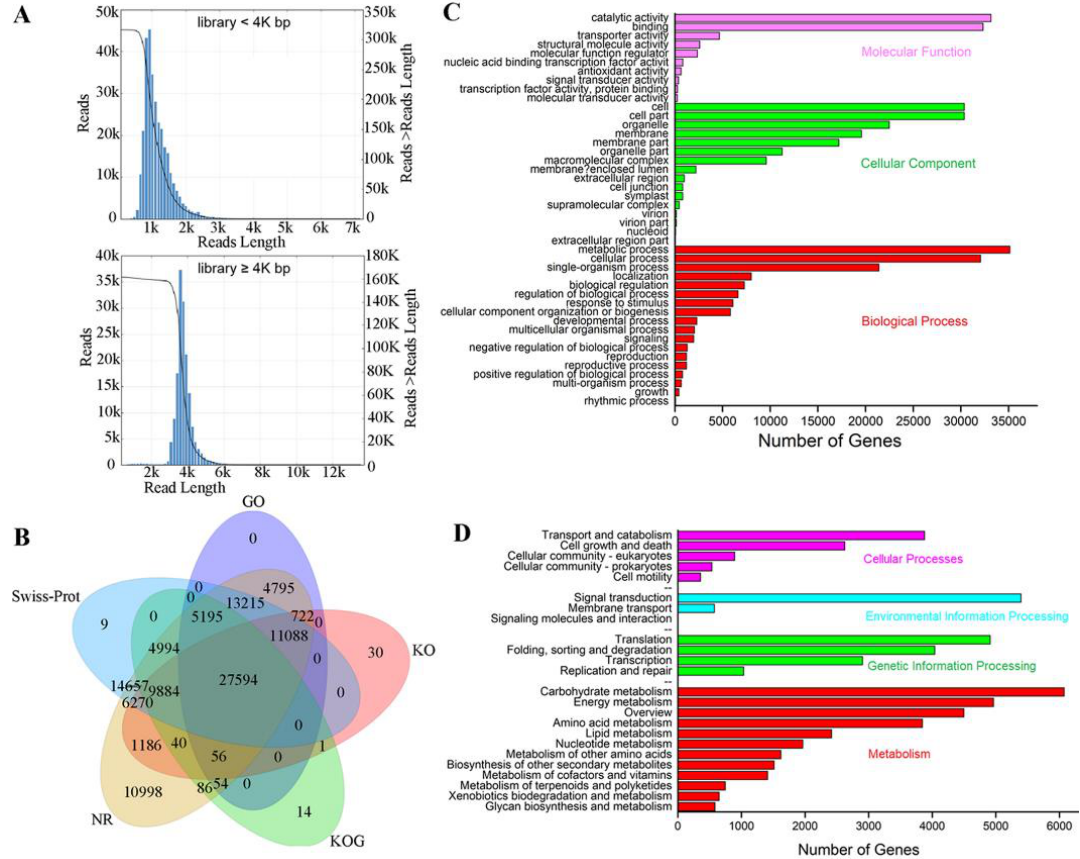
Figure 3. Analysis and functional annotation of full-length transcriptome data. ( A ) Full-length nonchimeric (FLNC) sequence length list. ( B ) The transcripts were annotated via five databases, and the results are displayed in a Venn diagram. ( C ) Gene Ontology (GO) enrichment analysis. ( D ) Kyoto Encyclopedia of Genes and Genomes (KEGG) enrichment analysis.